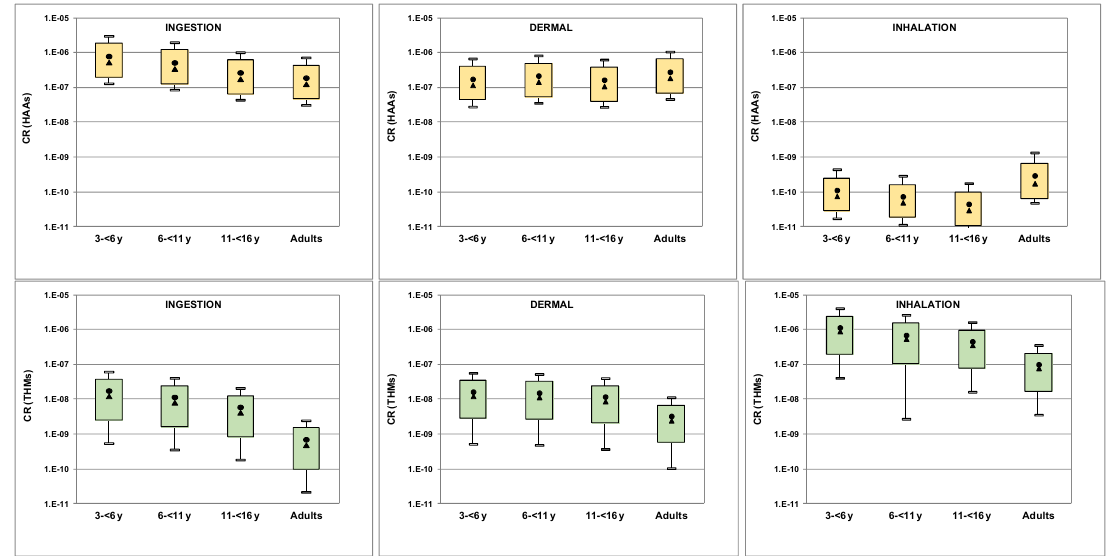
Figure 6. Carcinogenic risk through different exposure routes) for THMs and HAAs (boxplots represent 10th and 90th percentiles, min and max values; circle and triangle represent mean and median values, respectively).